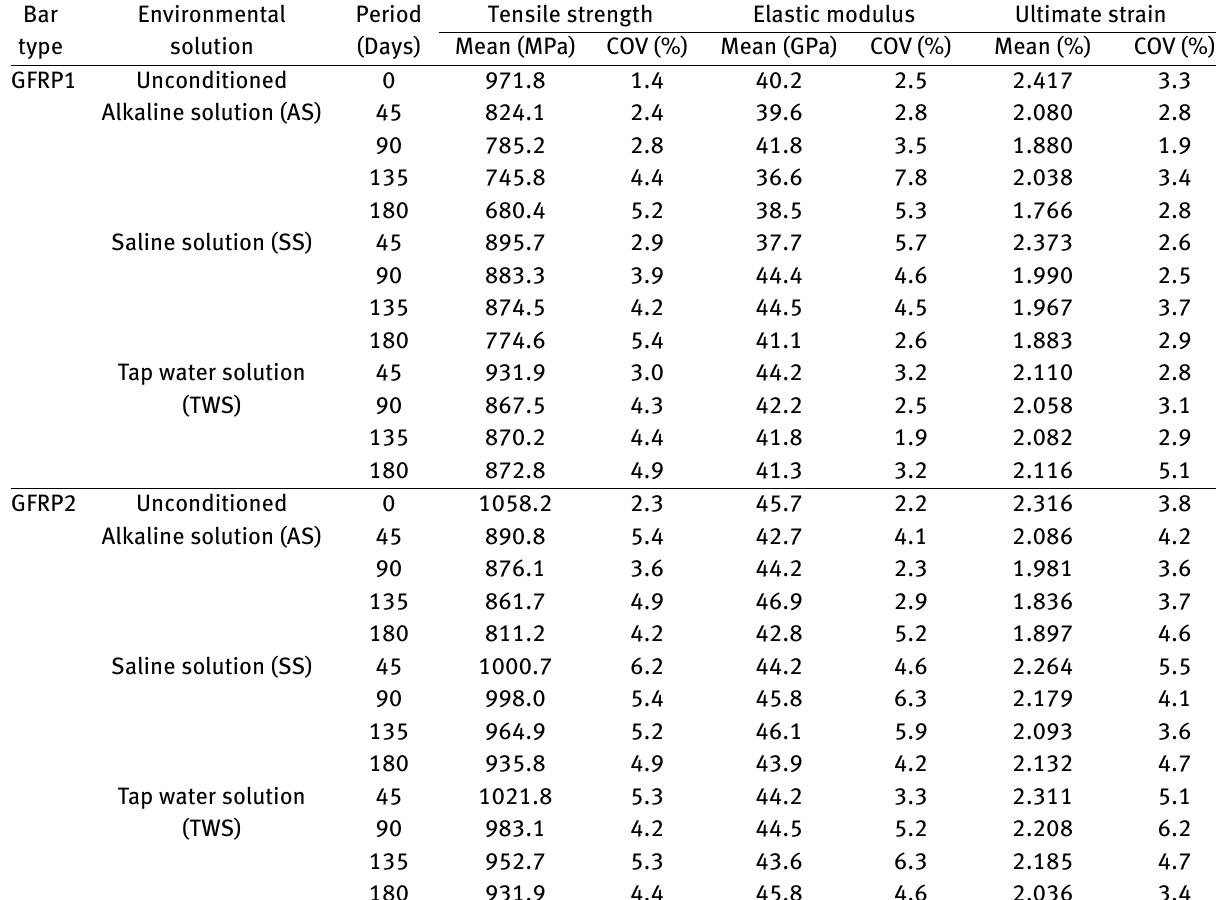
Table 2: Results of tensile test of all tested GFRP bars. Bar Environmental Period Tensile strength Elastic modulus Ultimate strain type solution (Days) GFRP1